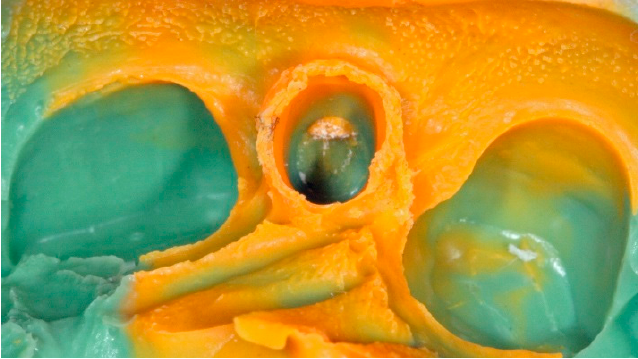
Figure 9. Conventional crown and bridge impression technique for implant abutment.